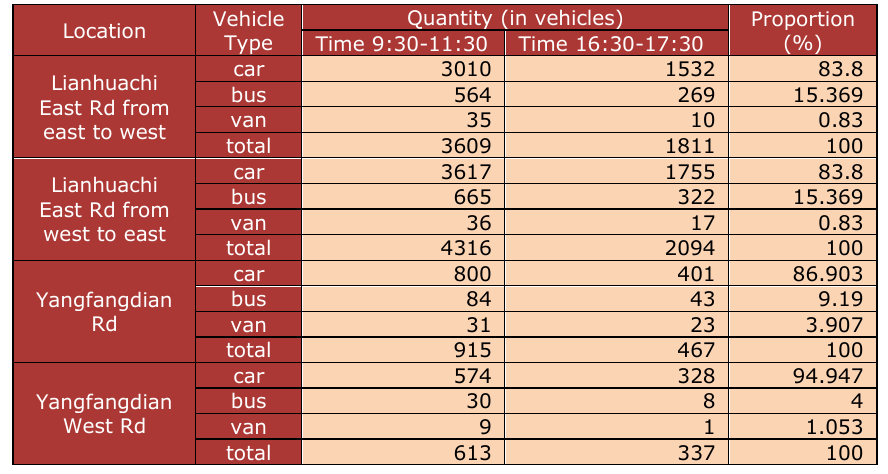
Table 1. The Survey Data of Traffic Flow in Beijing West Railway Station north